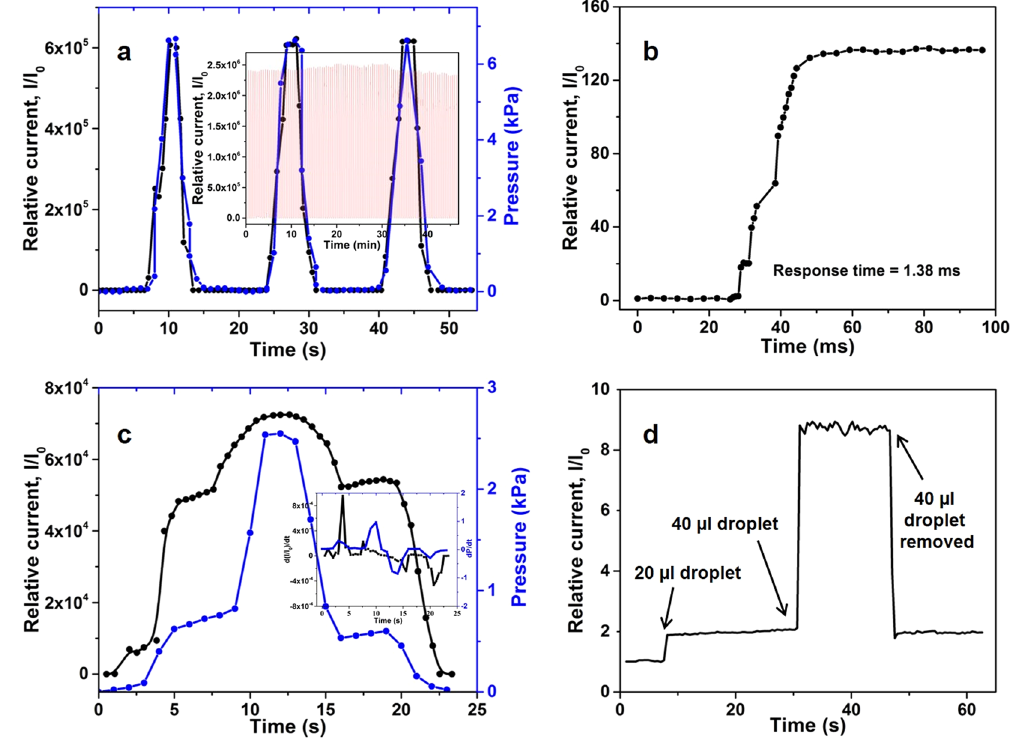
Figure 2. Tactile sensing characteristics of the device. ( a ) The relative current in the sensor increases more than 5 orders of magnitude on increasing the base pressure to ~6.5 kPa. The response from the device is robust as seen in the inset, where over 100 pressure cycles of 10 kPa are applied. ( b ) The device responds in less than 2 ms on being subjected to a 0.01 kPa step increase in load. ( c ) The device responds in step to both positive and negative changes in the pressure stimuli. The inset shows that the derivative of the response tracks that of the applied stimuli. ( d ) The device is sensitive to pressure changes due to placing of small water droplets. Both the initial placement of the droplet and subsequently another one were detected. The device also tracks the removal of one of the